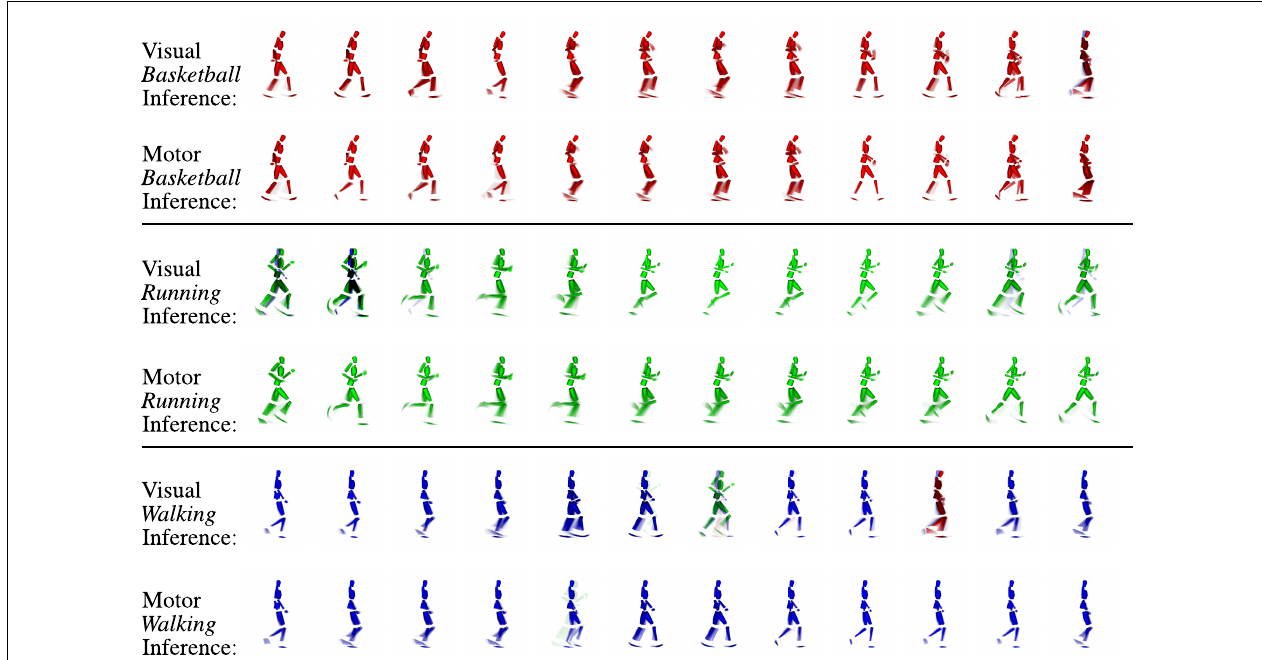
FIGURE 9 | Example clips of the state sequences recognized in the visual layer and inferred in the motor layer when observing three different movements ( basketball , running , and walking testing trials) . Each row shows the sequence of states by means of the representing snapshots over time (FLTR) for the respective modality and motion capture trial. Snapshots at the same position show the same time step in the sequence of visual and motor states and mostly show very similar parts of the movements. Because the inference is a stochastic process and because visual and motor states are not segmented in identical fashion as a result of the different information coding in the modalities, slight misalignments can occur. However, strong incongruence is avoided because of the visuomotor coupling. Moreover, although ambiguous patterns are included in the sequence, the network maintains the activation cycle of the movement-specific states because pattern transition probabilities are biased by top-down propagated intention signals.